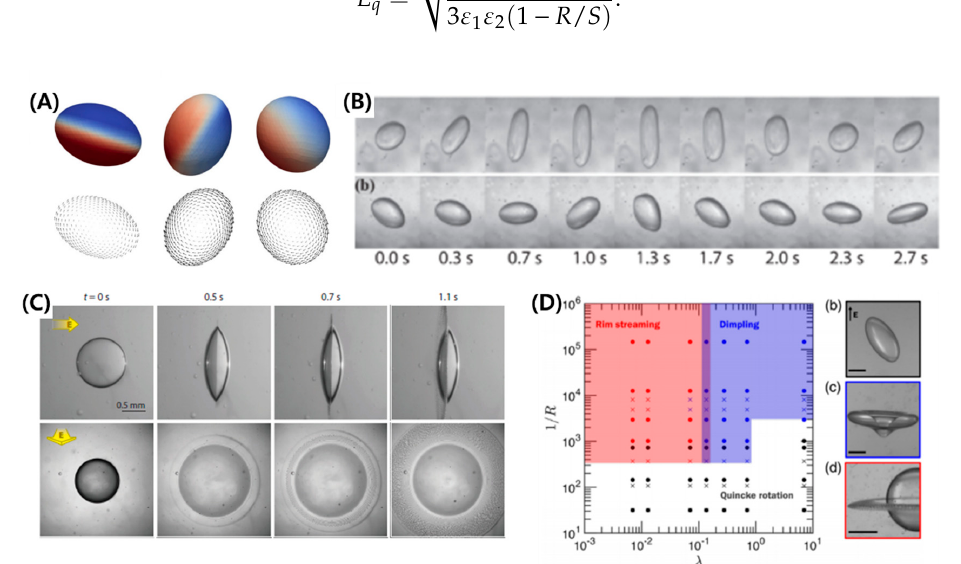
Figure 5. Instabilities of an oblate droplet under a strong electric field. ( A ) Electro-rotation of a droplet above the threshold electric field of Quincke effect [90] . ( B ) Irregular rotational motions [118] . ( C ) Equatorial streaming. ( D ) Mapping of different instabilities, such as electro-rotation, dimpling, and equatorial streaming [18] .